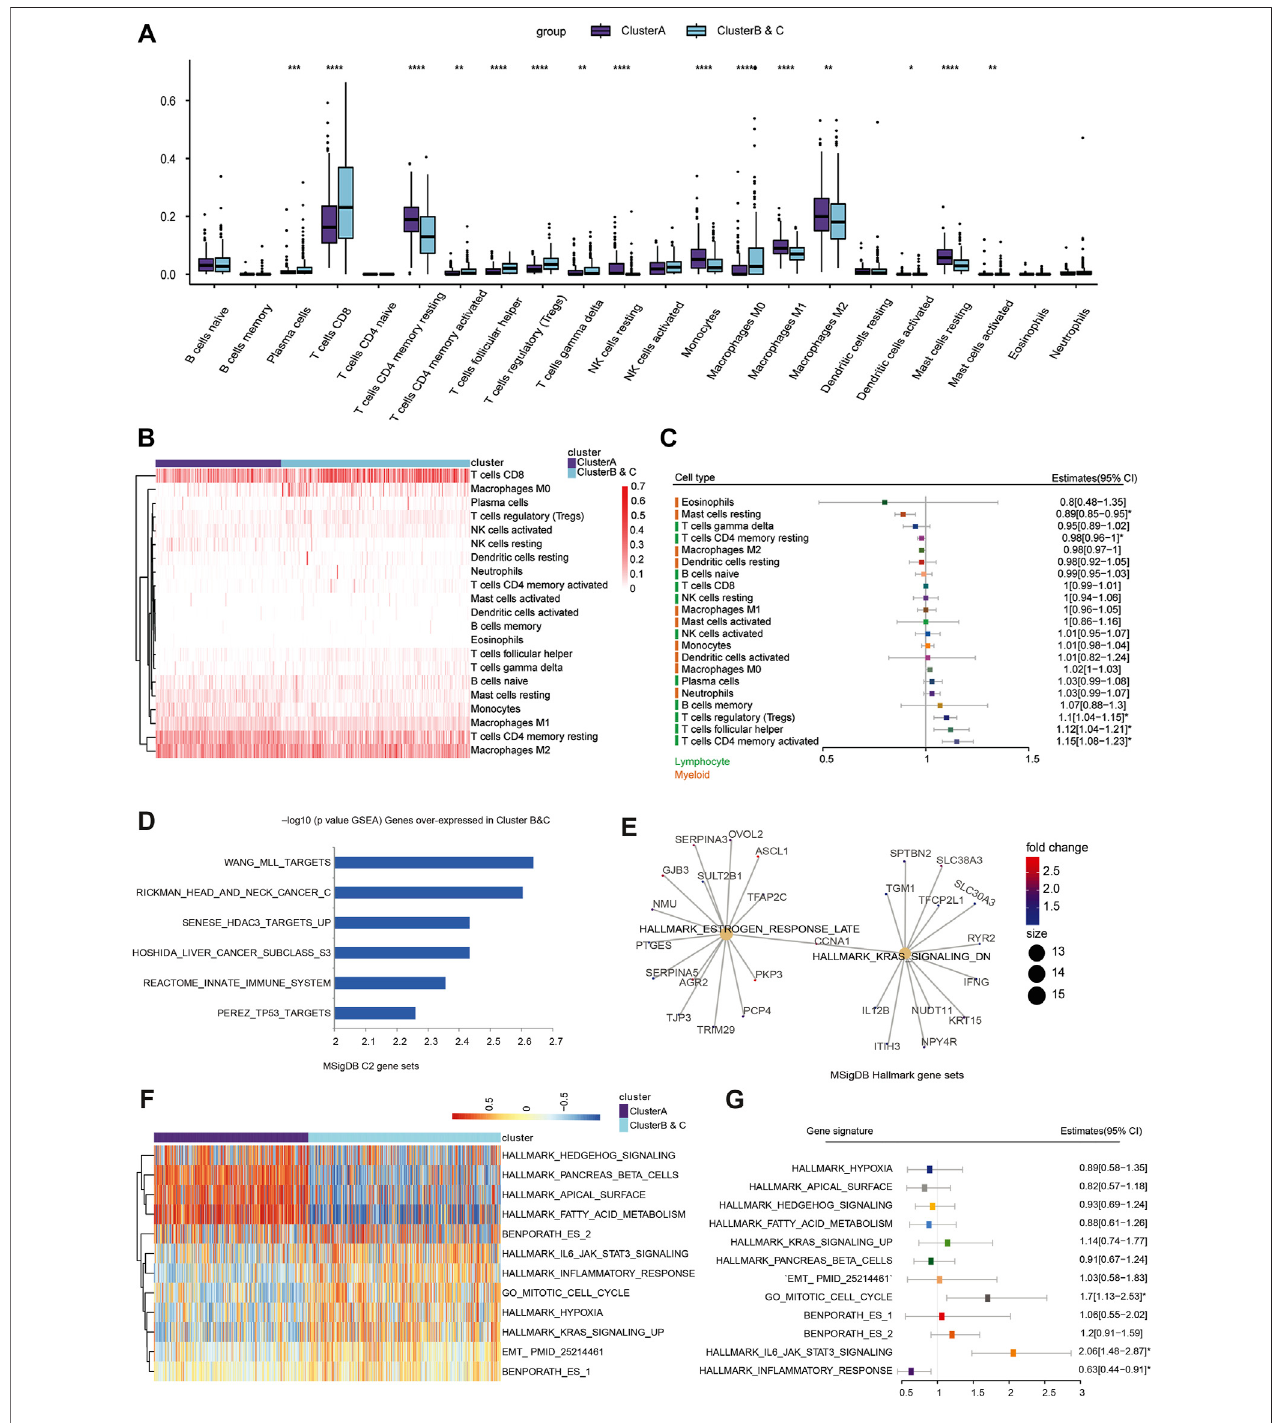
FIGURE 5 | Immune cell in fi ltration and function enrichment analysis of immunophenotyping clusters. (A, B) The CIBERSORT algorithm was performed to analyze theabsoluteproportionof22in fi ltratingimmunecellsandexploredifferentialimmunecelldistributioninccRCCsamplesfromTCGA. (C) Prognosticvalueoflymphocyte- derived and myeloid-derived immune cell in fi ltration using univariate Cox regression analysis in a forest plot. (D, E) To evaluate the differences in biological function between the two immunophenotyping clusters, the Wilcox test was used to identify DEGs in the two immunophenotyping clusters. According to the screening criteriaof|log 2 FC| > 1andadj.Pvalue < 0.01( SupplementaryMaterials ),GSEAwasusedtoexplorethefunctionalannotationsofupregulatedDEGsinClustersBandC. (F) The GSVA algorithm suggested signi fi cantly enriched hallmarks in Cluster A and Clusters B and C. (G) Generalized linear model Cox regression model was used to test the contribution of each function to Clusters B and C and Cluster A.